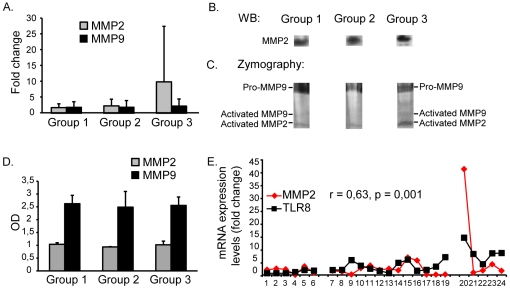
Expression of the MMP2 and MMP9 in kidneys of BW mice.Data demonstrate an insignificant increase in renal MMP2, but not in MMP9 mRNA levels in Group 3 mice compared with mice from Group 1 and 2 (A), and a corresponding increase in MMP2 protein (western blot, B) or in activated MMP2 (zymography, C). Serum concentrations of MMP2 and MMP9 were stable in all stages of the disease as demonstrated by quantitative ELISA for MMP2 and MMP9 (Figure 3D). In agreement with the hypothesis that MMP2 gene expression is linked to activation of TLRs, TLR8 correlates significantly with expression of MMP2 (r = 0,63, p<0,001, E).